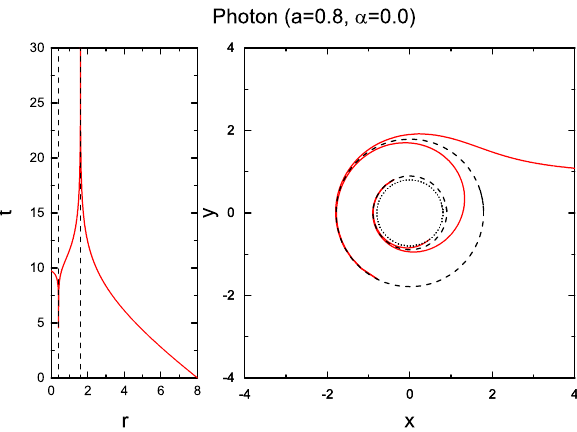
Fig. 1 The trajectory of a photon in the case of the Kerr black hole with a = 0 . 8 (in the figure, we set M = 1). The trajectory of a photon is plotted by the solid line , two horizons are illustrated by the dashed circles andtheringsingularityisshownby shortdotcircle .Inthe ( x , y ) - √ √ r 2 + a 2 cos φ and y = r 2 + a 2 sin φ . As a photon plane, x = approaches the Kerr black hole, it has a discontinuous orbit at the outer and inner horizons ( r + = 1 . 6 and r − = 0 . 4). That is, the motion of the photon reverses at the horizons (see the left panel ); thereafter, it is bending to the ring singularity